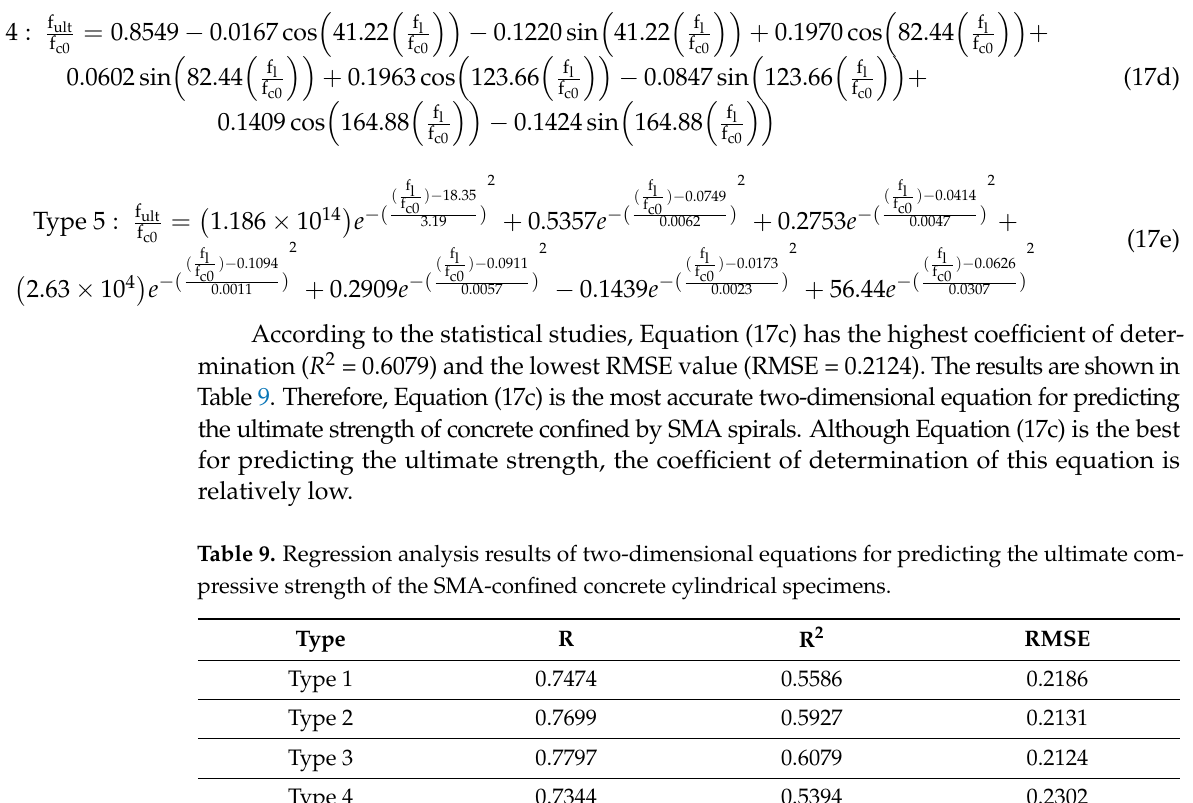
Figure 12 compares the (cid:3033) (cid:3296)(cid:3287)(cid:3295) values obtained from the proposed model (Equation (cid:3033) (cid:3278)(cid:3116) (17c) and experimental results. This comparison indicates that the model prediction and the test results correspond closely.